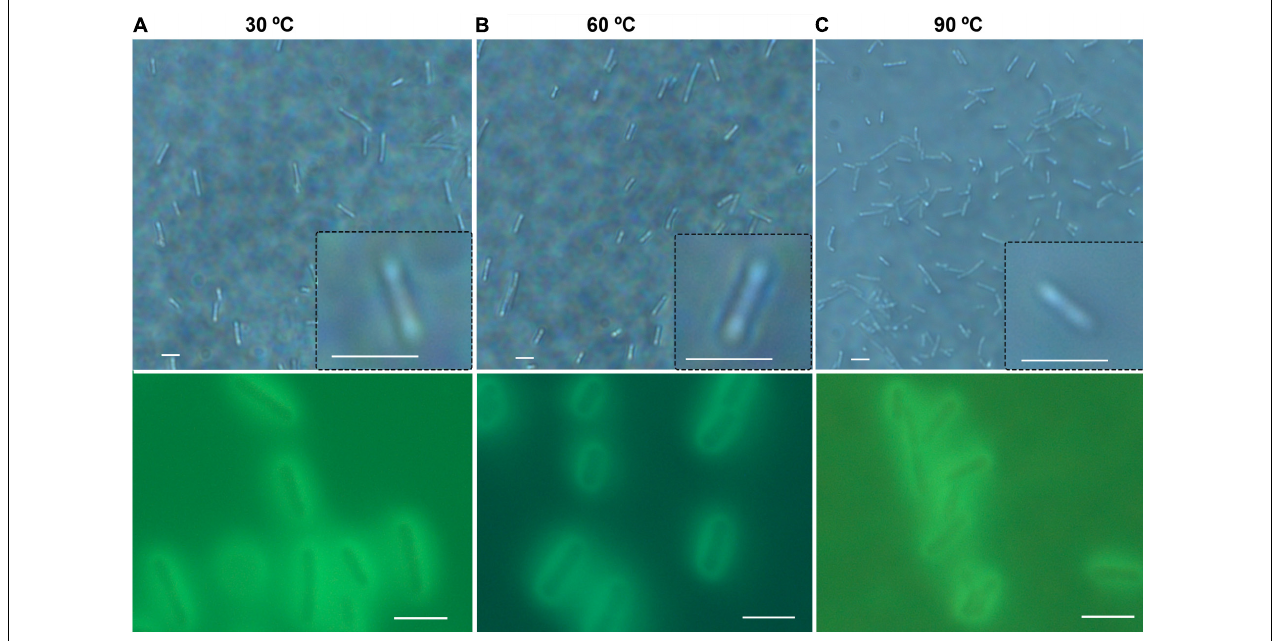
FIGURE 3 | General appearance and size of B. subtilis at normal and elevated temperatures. Shown are phase contrast (top row) and autofluorescence (bottom row); scale bar = 5 µ m. (A) 30 ◦ C. (B) 60 ◦ C. (C) 90 ◦ C.